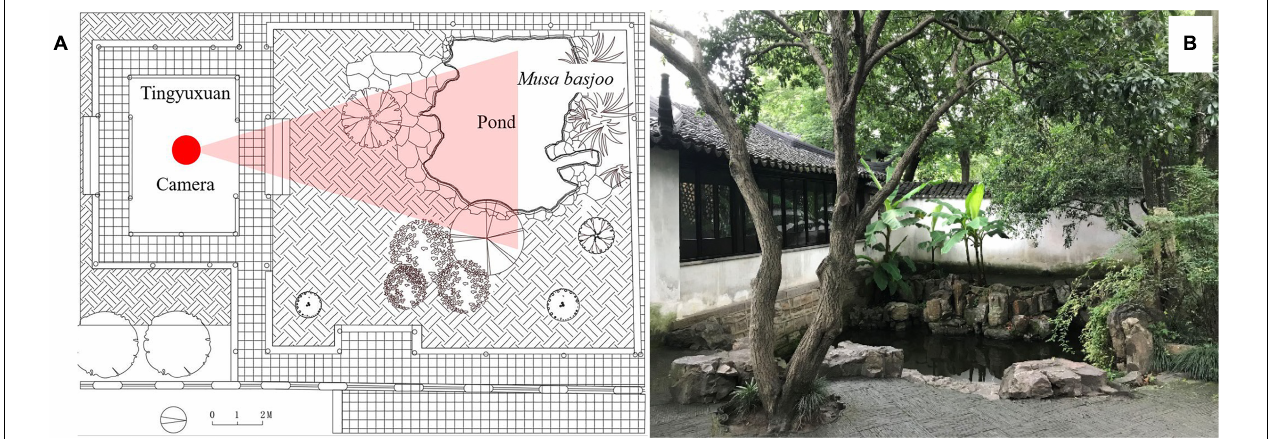
FIGURE 1 | (A) The plan of Rain Hall [The red dots indicate the perspective at which the photograph (B) was taken]. (B) The image of the site (The video of the experiment at the later part is at the same perspective as the